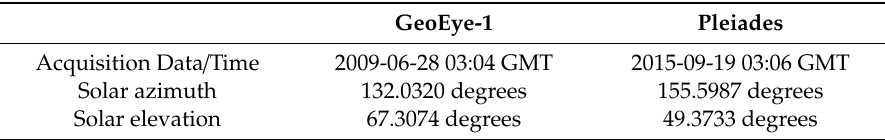
Table 1. The information about high resolution